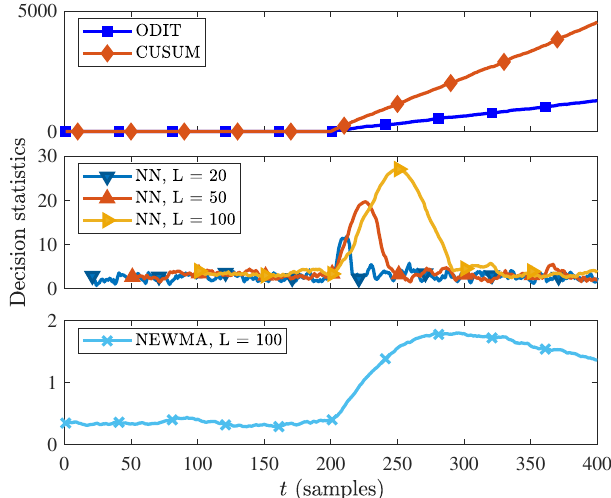
Figure 5. Decision statistics of ODIT, CUSUM, NN and NEWMA methods in the synthetic change- in-the-mean